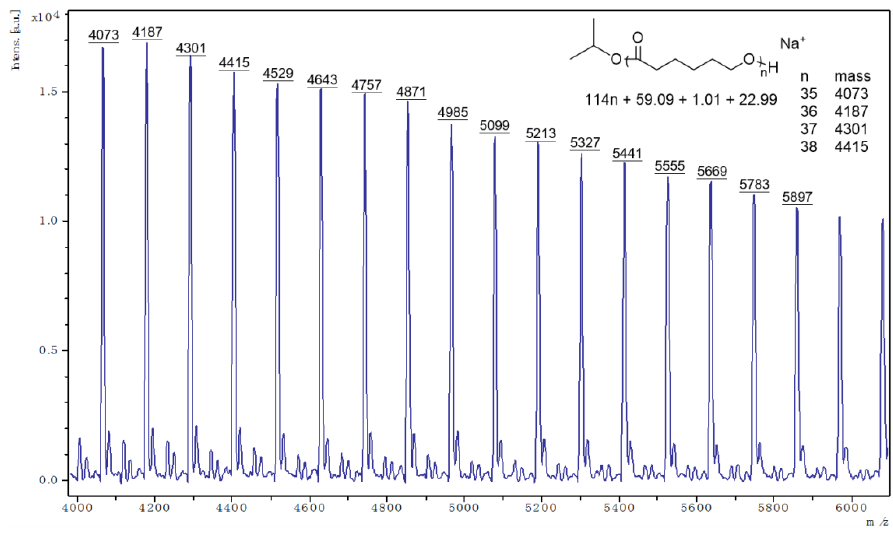
Figure 12. 1 H NMR spectrum (CDCl 3 , 400 MHz) of PCL prepared using 8 (Table 1, entry 8).